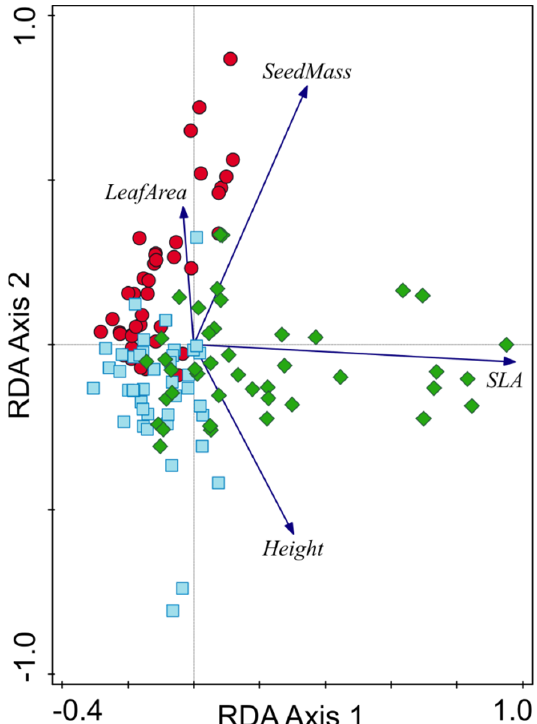
Figure 8. RDA diagram visualizes the distribution of investigated plots plotted against the community weighted means of functional traits (CWMs) within three surveys conducted in the riparian forest reserves in the Odra River Valley (SW Poland). Explanation: red circles—1960; blue squares—1990, green diamonds—2020.